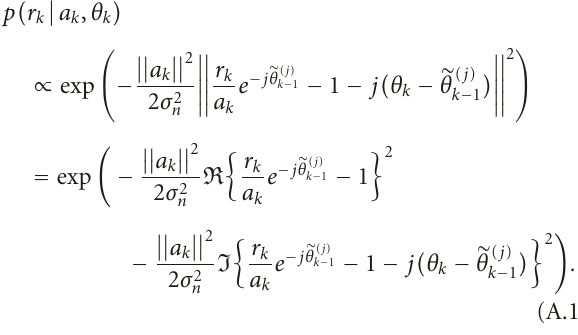
Figure 4: BER performance for coded setup as function of number = 2 ◦ , E = 5dB, QPSK, 5% pilots). of samples ( σ 2 b /N 0 δ